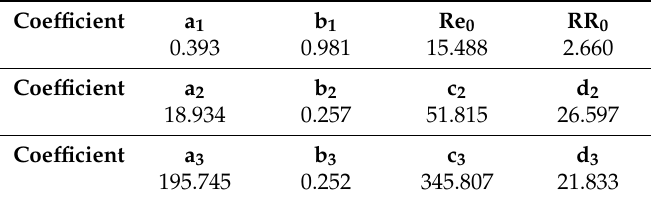
Table 1. Coefficients for the relationships between the RR and Re/Tau/ LWP.